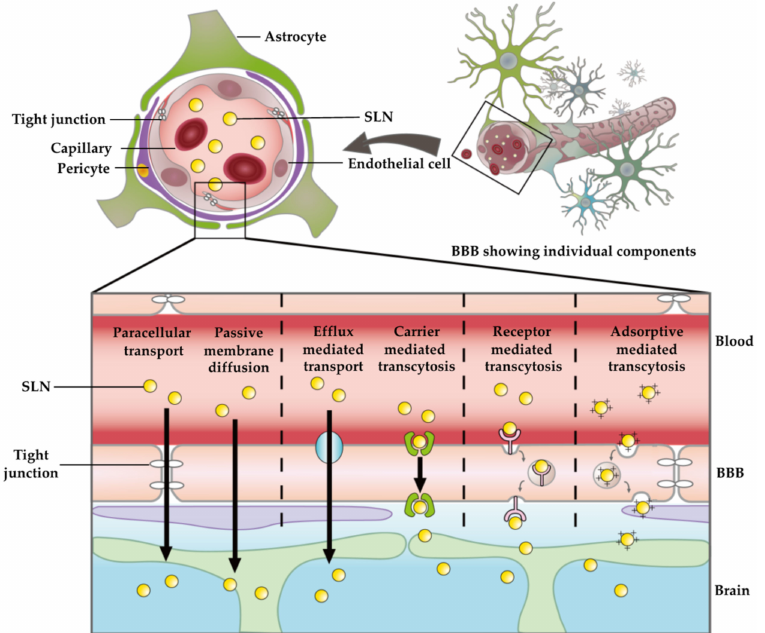
Figure 4. BBB showing individual components and how the drug loaded SLNs can cross the BBB by different physiological mechanisms such as: Paracellular pathway and passive transmembrane diffusion; Protein mediated transport; Receptor-mediated transcytosis (RMT); and Adsorptive- mediated transcytosis